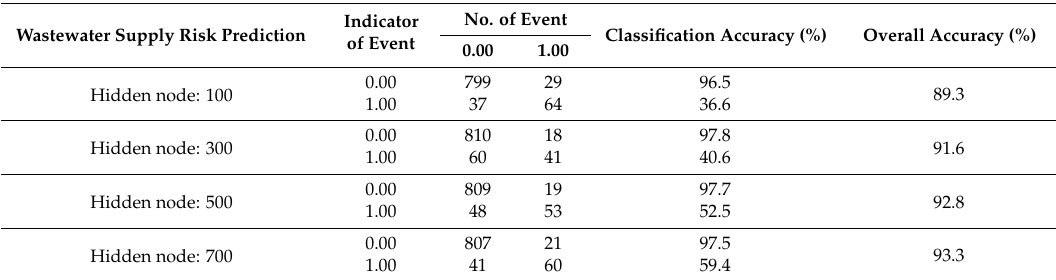
Table 5. Analysis of wastewater risk prediction model using